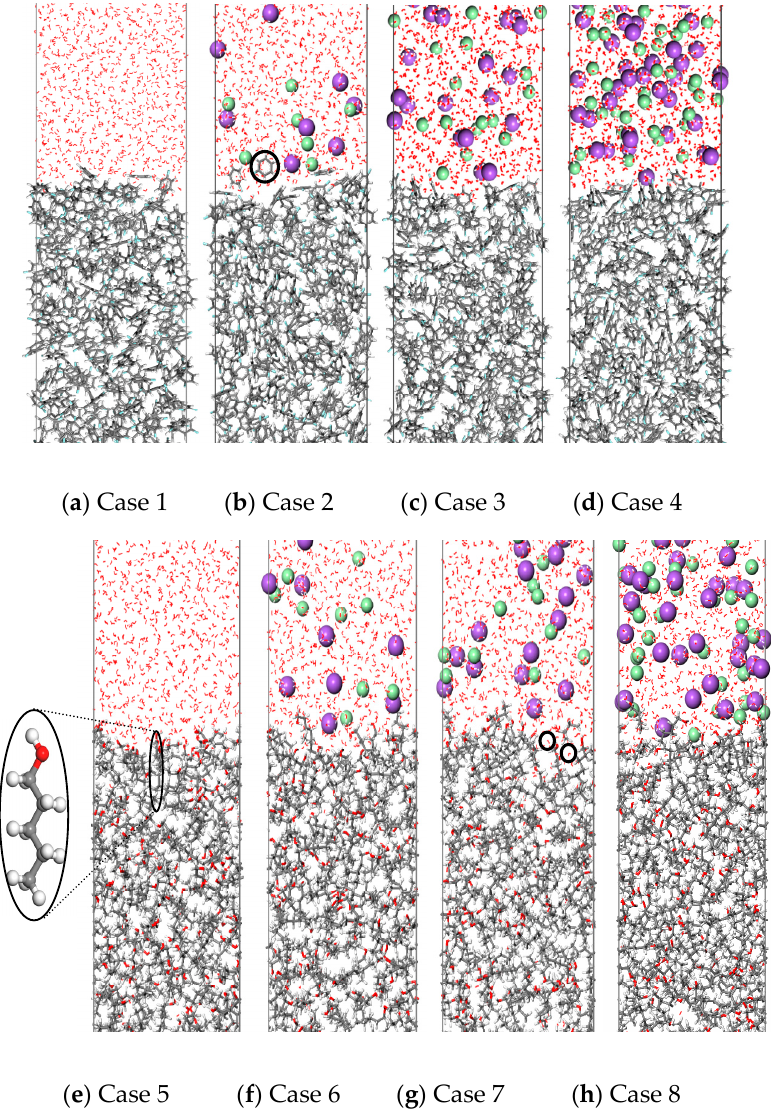
Figure 3. Simulation of oil–water interface in different systems after 1 ns molecular dynamics simulation: ( a – d ) Fluorobenzene–NaCl aqueous solution system containing different concentrations of ions; ( e – h ) 1-Pentanol–NaCl aqueous solution system containing different concentrations of ions.